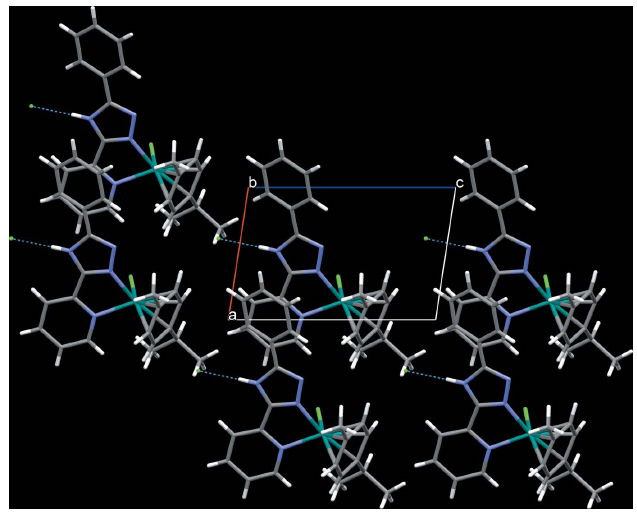
Figure 2 A crystal packing diagram (view along the b axis) of the title compound.